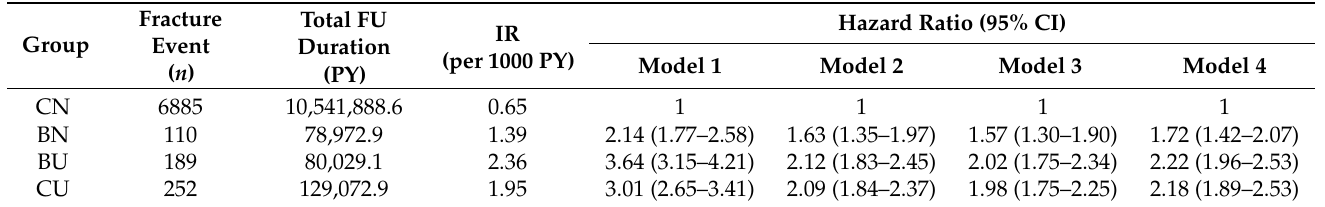
Table 2. Hazard ratios for hip fracture according to changes in underweight status in adults ≥ 40 years old.